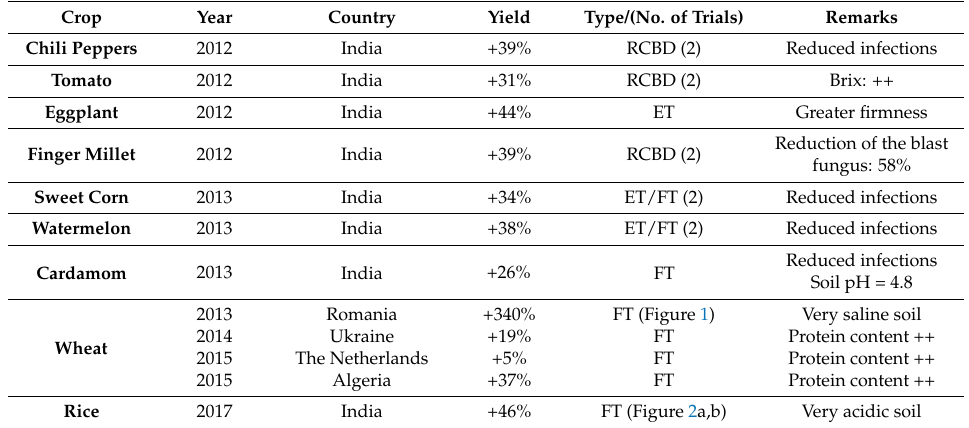
Table 2. The effects of applying AB Yellow ® (PEG-sSA (2.5%) plus boric acid (0.4%), molybdenum (0.1%) and zinc (1.5%), to several crops during the period 2012 to 2017.